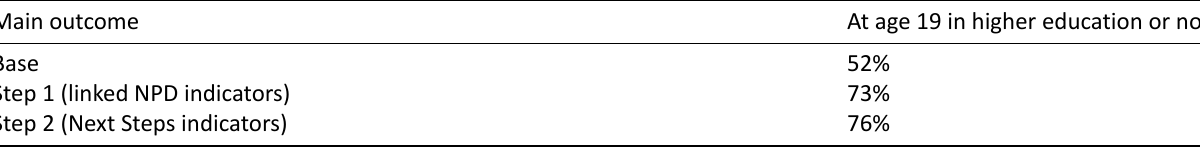
Table 8. Summary of correctness of prediction of higher education entry using Next Steps–NPD data. Main